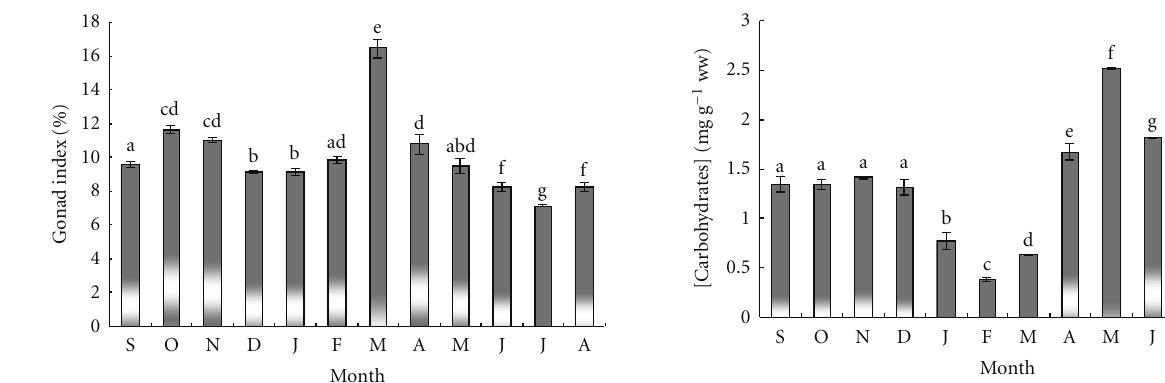
Figure 1: Paracentrotus lividus . Monthly variation of gonad index. Columns with the same letter are not significantly di ff erent.